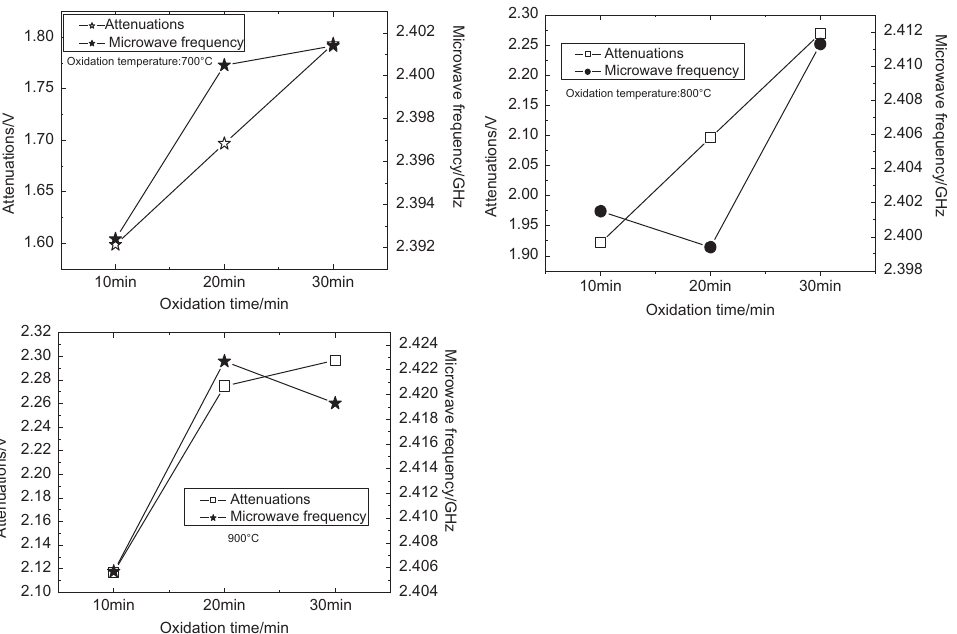
Figure 5: Effect of oxidation time on the attenuation and microwave frequency of oxidation products treated at 700 (top), 800 (middle) and 900°C (bottom) from the – 80 + 120 mesh ilmenite